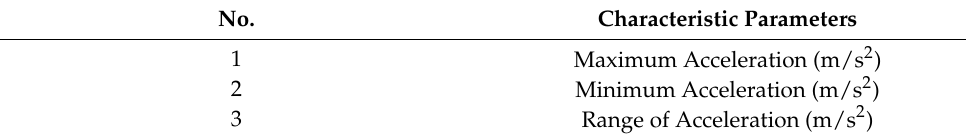
Table 2. Table of vertical characteristic